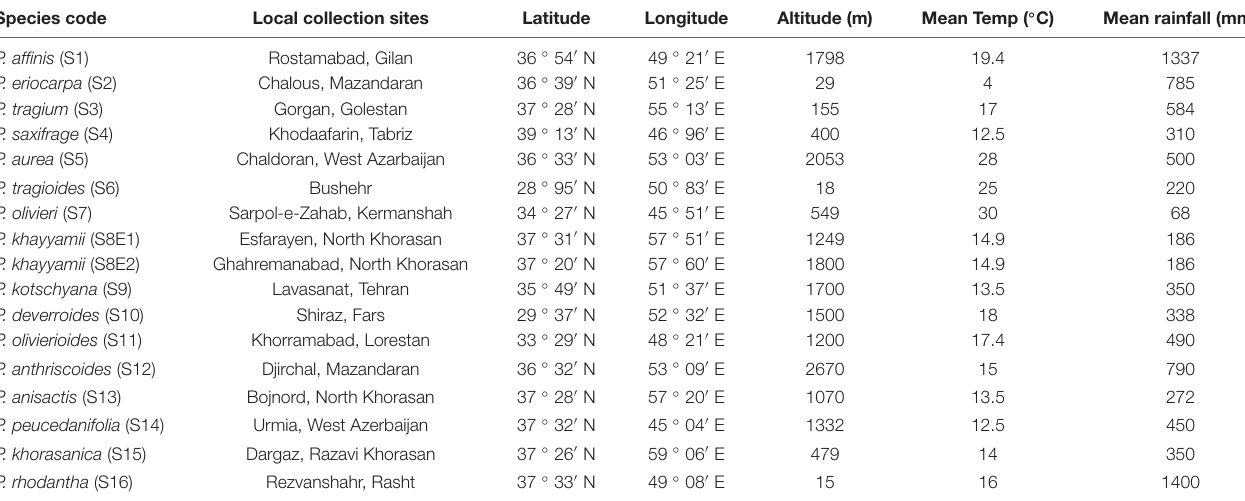
TABLE 1 | Local features of indigenous harvested Iranian Pimpinella species were analyzed.